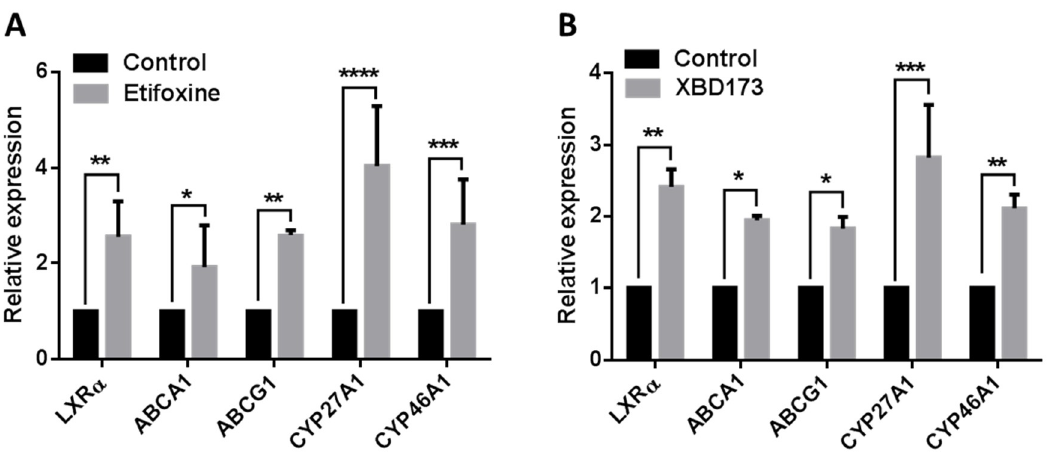
Figure 2. The effects of TSPO ligands on the expression of cholesterol efflux genes and metabolism genes in RF6A cells treated with Etifoxine ( A ) or XBD173 ( B ) were quantified by qRT-PCR. The RF/6A cells were cultured and treated with TSPO ligands Etifoxine (20 µ M) and XBD173 (25 µ M) and with 0.1% DMSO as a control for 24 h. All data were collected and analysed relative expression of β -actin and presented as mean ± SD. Statistical comparisons were done using Two-way ANOVA followed by Bonferroni test. NS: non-significant, * p ≤ 0.05; ** p ≤ 0.01; *** p < 0.001 and *** p ≤ 0.001.